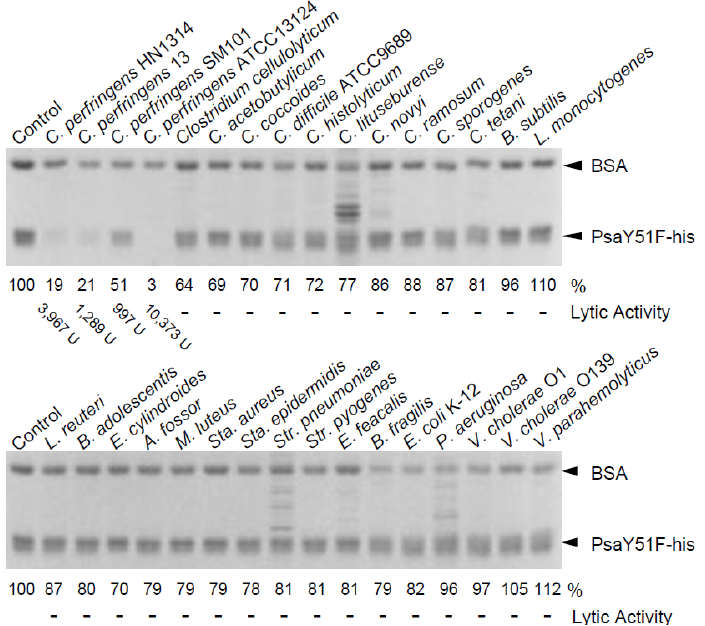
Figure 4. Cell binding by PsaY51F-his. Cell binding activity was measured as described in the Materials and Methods. Purified PsaY51F-his and the non-binding internal standard, bovine serum albumin (BSA) were combined with cells of a variety of bacterial species (indicated above each gel) or buffer (Control; no cells); the mixtures then were centrifuged, and the resulting supernatants were analyzed by 12.5% SDS-PAGE. Image analysis was used to quantify the intensity (in %; indicated below the gel) of the band of remaining PsaY51F-his following incubation with each bacterium; the intensity of the band in the Control (no cells) was defined as 100%. The lytic activity showed the values in Table